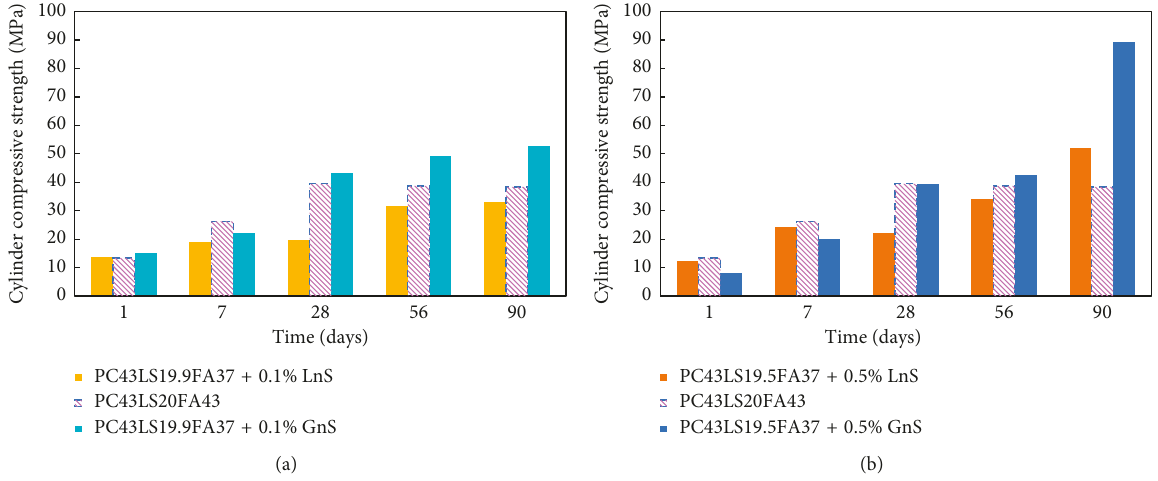
Figure 7: Comparison of the (a) 0.1% GnS or 0.1% LnS and (b) 0.5% GnS or 0.5% LnS modification of cementitious nanocomposite binders based on PC43LS20FA37. Figure 10. The drastic reduction in the Ca(OH) 2 content observed at day 56 in Figure 10 could be related to the marginal increase in CaCO 3 observed at the same age, implying the occurrence of carbonation rather than chemical reactivity of the LS present in the paste. On the contrary, the TGA curves, covering 0–1000 ° C, presented in